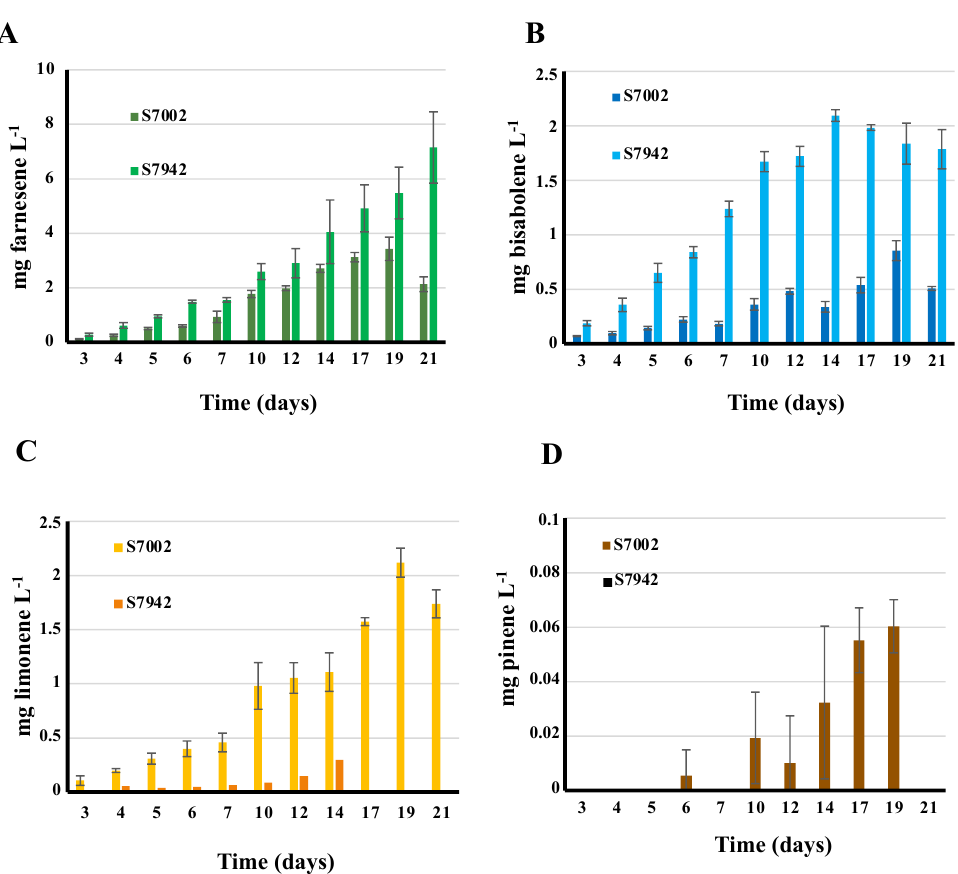
Figure 4. Comparison of the levels of terpene production by the Synechococcus PCC 7002 and Synechococcus elongatus PCC 7942 strains expressing a terpene synthase gene from the following plasmids: ( A ) pCFS (farnesene synthase), ( B ) pCBS (bisabolene synthase), ( C ) pCLS (limonene synthase) and ( D ) pCPS (pinene synthase). Cells were grown under dodecane (20% vol/vol) in otherwise standard photoautotrophic conditions to assay terpene production for 21 days. Error bars represent standard deviation from n ≥ 2 biological replicates. Note that note that no pinene was produced by S.7942